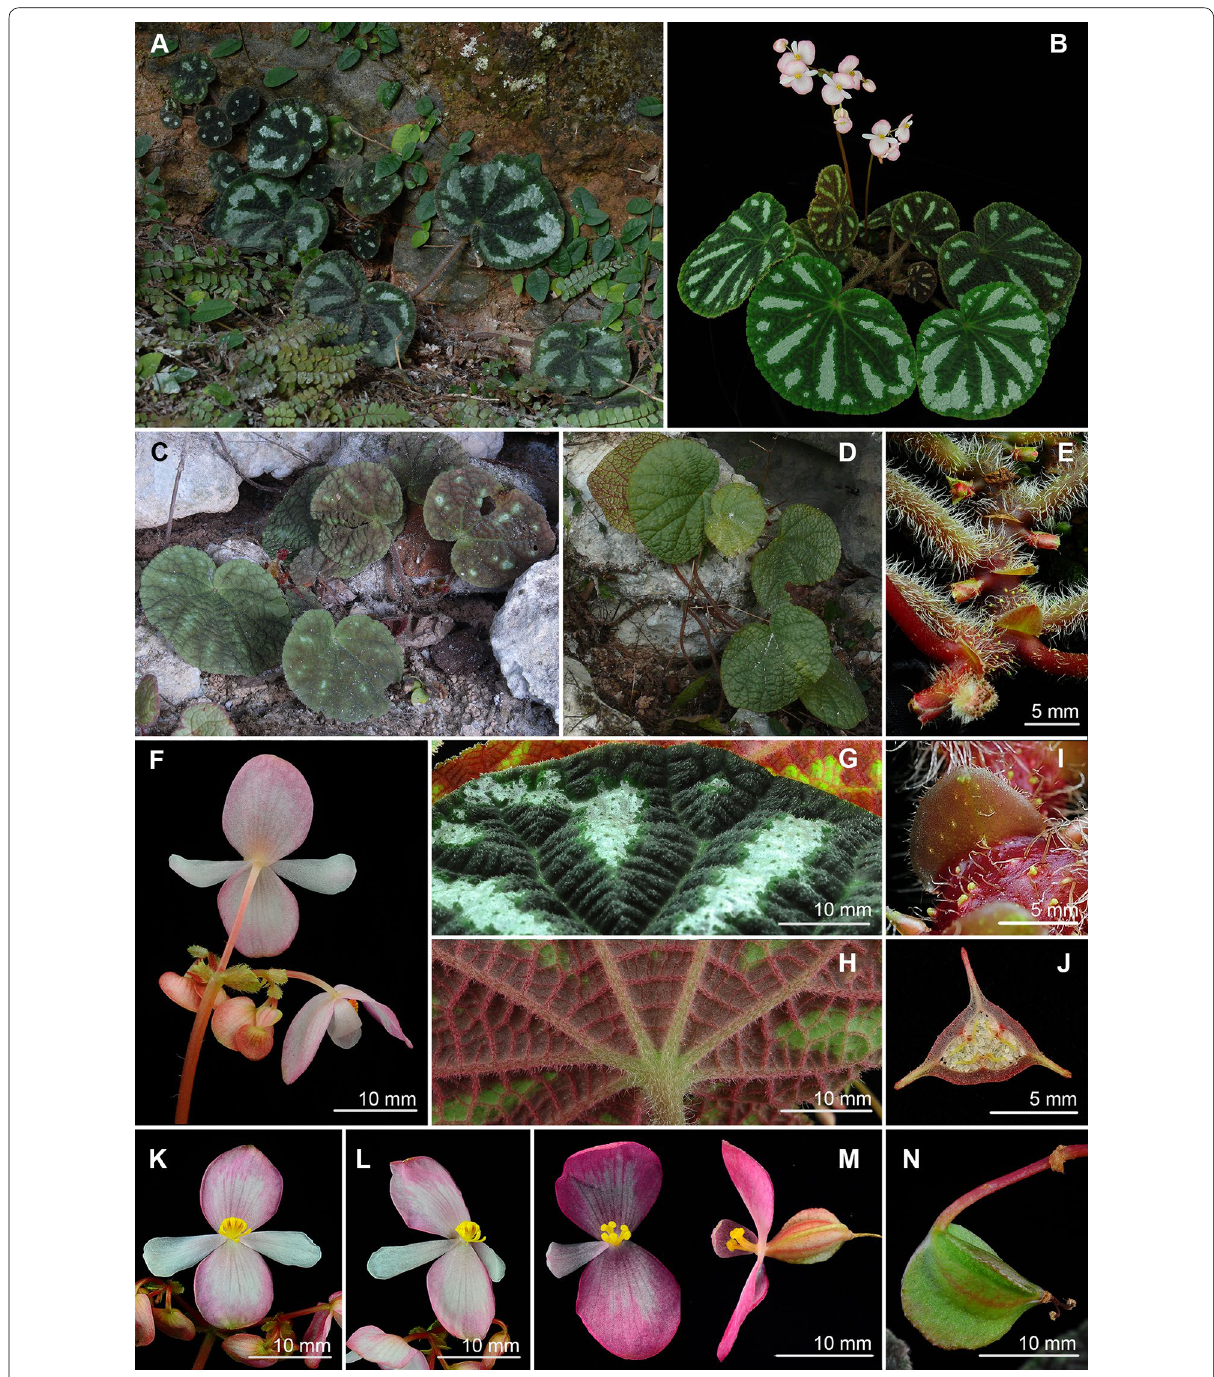
Fig. 11 Begonia lui S.M.Ku, C.I Peng & Yan Liu. A , C , D Habitat and habit, also showing the variation of maculation on leaves among individuals; B Plant at anthesis; E Rhizome; F Inflorescences and bracts; G Leaf adaxial surface; H Leaf abaxial surface; I Stipule; J Ovary cross section; K , L Staminate flowers; M Pistillate flower; N Fruit. All from Peng et al .